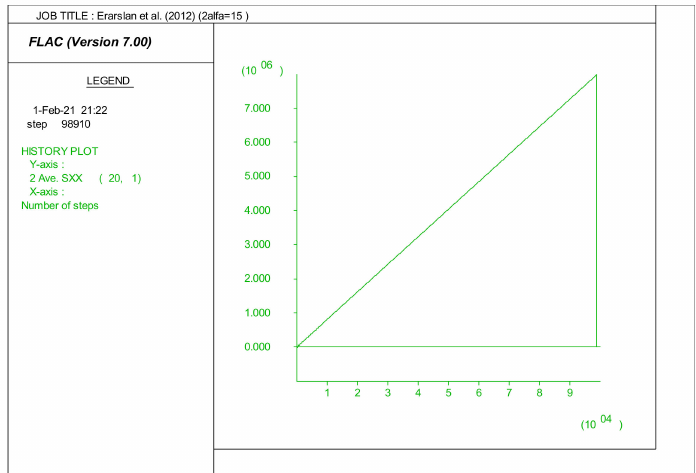
Figure 4. Evolution of the horizontal stress in the center of the disk tested by [6] versus the number of